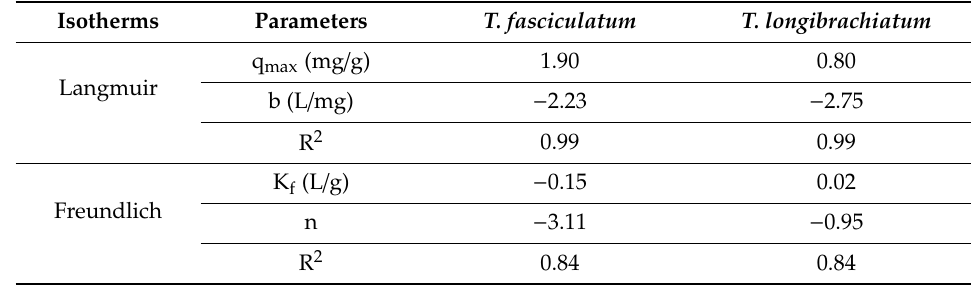
Table 2. Langmuir and Freundlich isotherm constants for removal of Cd 2 + by T. fasciculatum and T. longibrachiatum.